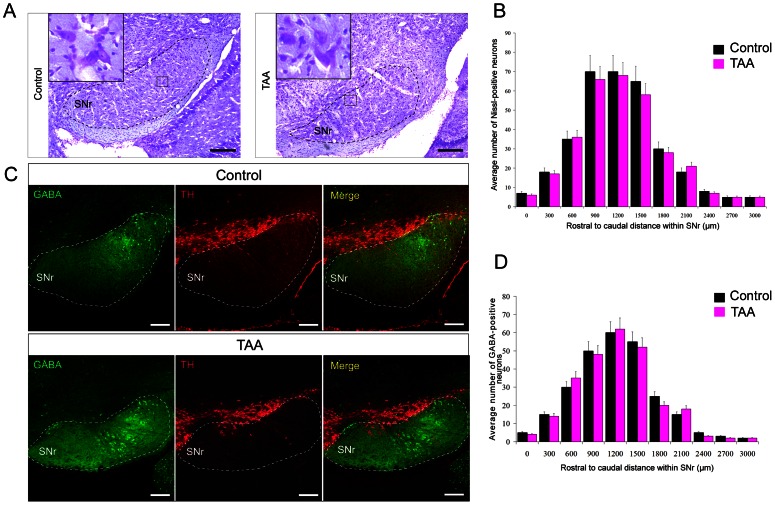
TAA did not alter the number of Nissl - positive and and GABAergic neurons within the SNr.(A) Representative Nissl staining in SNr neurons of normal control (control) mice and TAA - injected (TAA) mice. The borders of the SNr were indicated by the black dotted line. Inset showing high magnifications of selected square area of Nissl - staining section indicated there was no morphological difference between normal and TAA-injected mice. (B) Graph displaying no alteration of the distribution of Nissl - positive neurons within the SNr between control and TAA groups. (C) Immunohistochemical analysis of GABAergic neurons (green) in the SNr of normal control (control) mice and TAA - injected (TAA) mice. TH-immunohistochemistry (red) was used to determine the location and outline of the SNr of the sections, and the borders of the SNr are indicated by the white dotted line. (D) Graph displaying no changes in the distribution of GABA - immunoreactive neurons within the SNr between control and TAA groups. Bars in A and C = 100 µm.